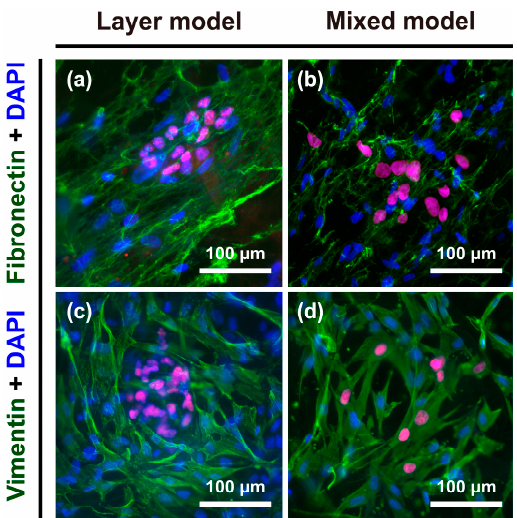
Figure 5. Immunofluorescence images of fibronectin and vimentin staining in Hep G2 cells and fibroblasts. Expression of fibronectin in the ( a ) layer model and ( b ) mixed model; expression of vimentin in the ( c ) layer model and ( d ) mixed model.